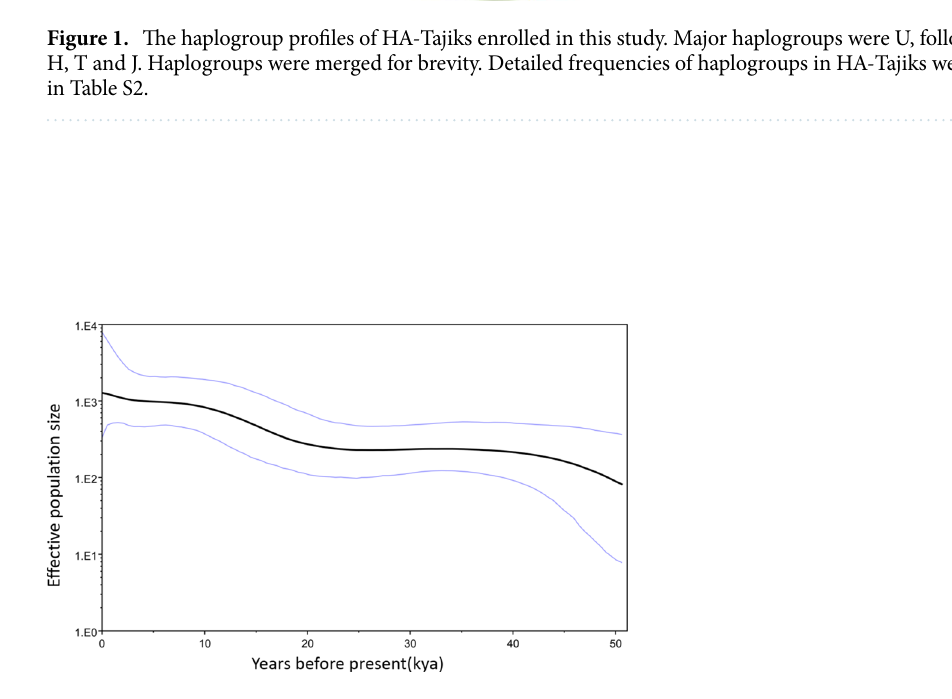
Figure 2. Bayesian Skyline Plot of HA-Tajik population history. BSP obtained by BEAST showed population history predicted from mitochondrial coding regions of 80 HA-Tajik subjects. The black line in the middle indicates the median population size predict from Bayesian posterior distribution. The population expansion may start from 10–15 kya before